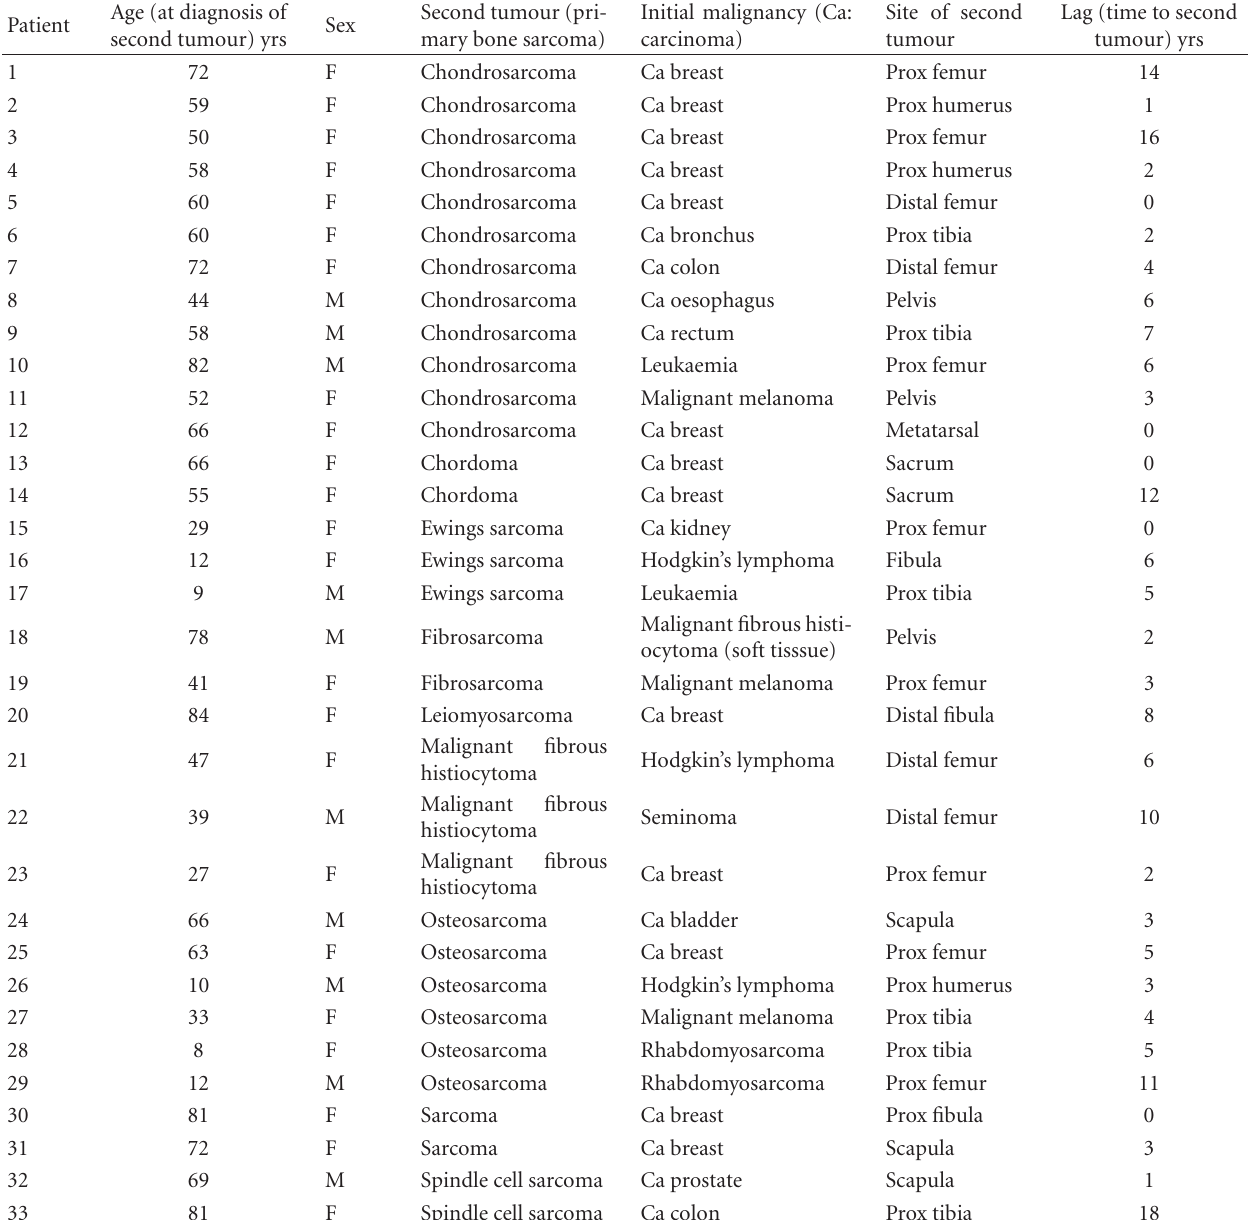
Table 1: Data for the Group 3 patients, in whom there was no clearly defined association between malignancies.